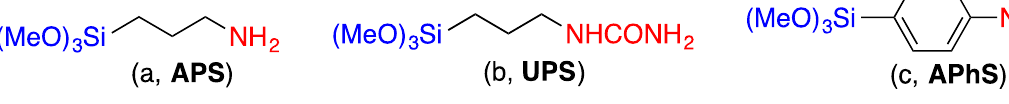
surface: ( a ) XPS of –NH 2 group of 1 month old sample; and 2